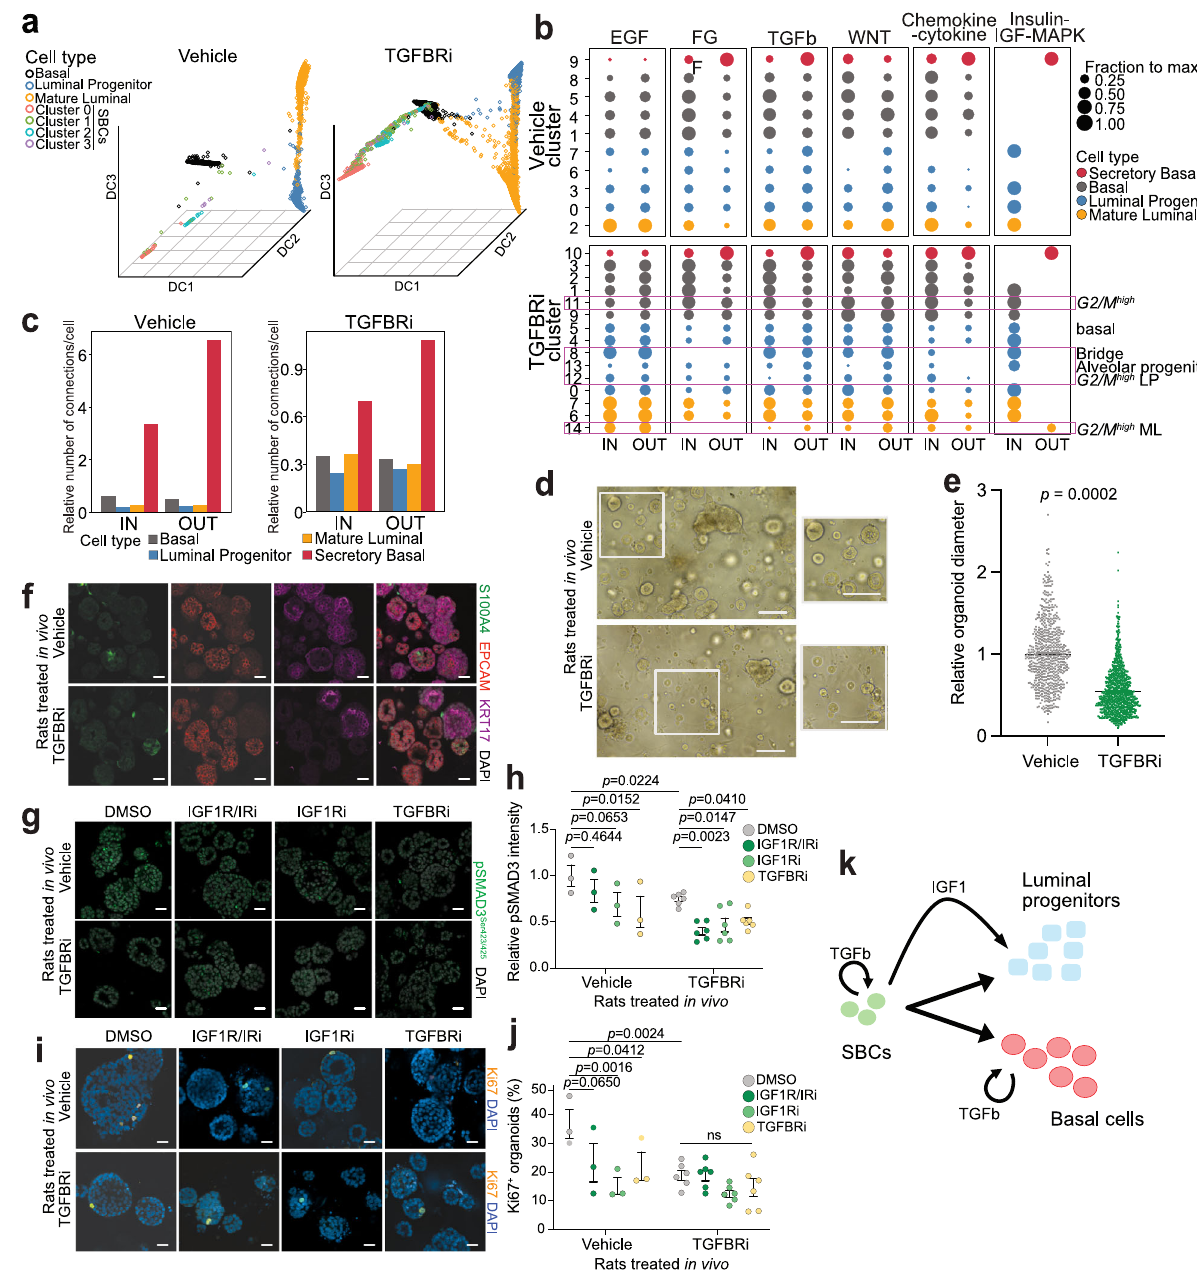
Fig. 5 | Functional relevance of TGFBRi-induced changes in the mammary epithelium. a Diffusion maps of mammary epithelial cells from control and TGFBRi-treated SD rats. b Cell type-speci fi c inferred connectivity among selected signaling pathways from interactome analysis in SD control and TGFBRi-treated rats. Clusters refer to the integrated data in Fig. 3c, with selected clusters high- lighted. The size of dots is the fractional number of either IN or OUT connections per cluster per pathway, normalized across clusters. IN — incoming (target); and OUT — outgoing (source) signals. c Relative number of inferred interactome con- nections per cell, aggregated by cell type. d Representative images of organoid cultures from the vehicle and TGFBRi-treated SD rats. e Plot depicting quanti fi ca- tion of relative organoid diameter. Organoids were derived from animals treated with vehicle ( n =3) or TGFBRi ( n =6). Two wells/animal were used